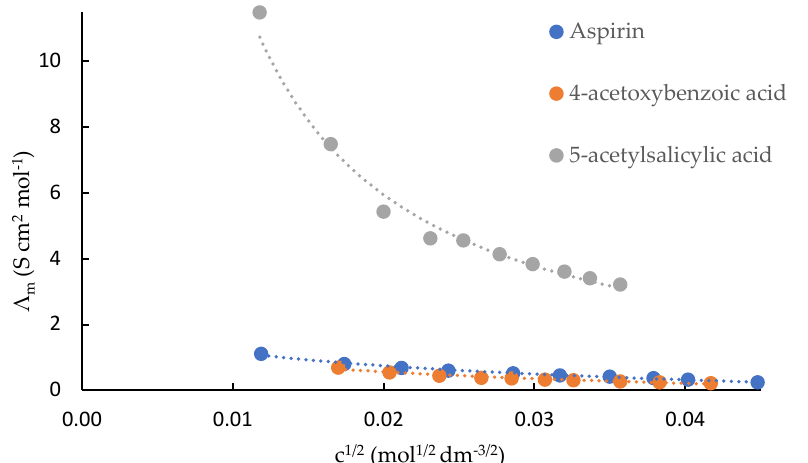
Figure 3. Conductance measurements of acetylsalicylic acid (aspirin), 4-acetoxybenzoic acid and 5-acetylsalicylic acid in DMF at 298.15 K.